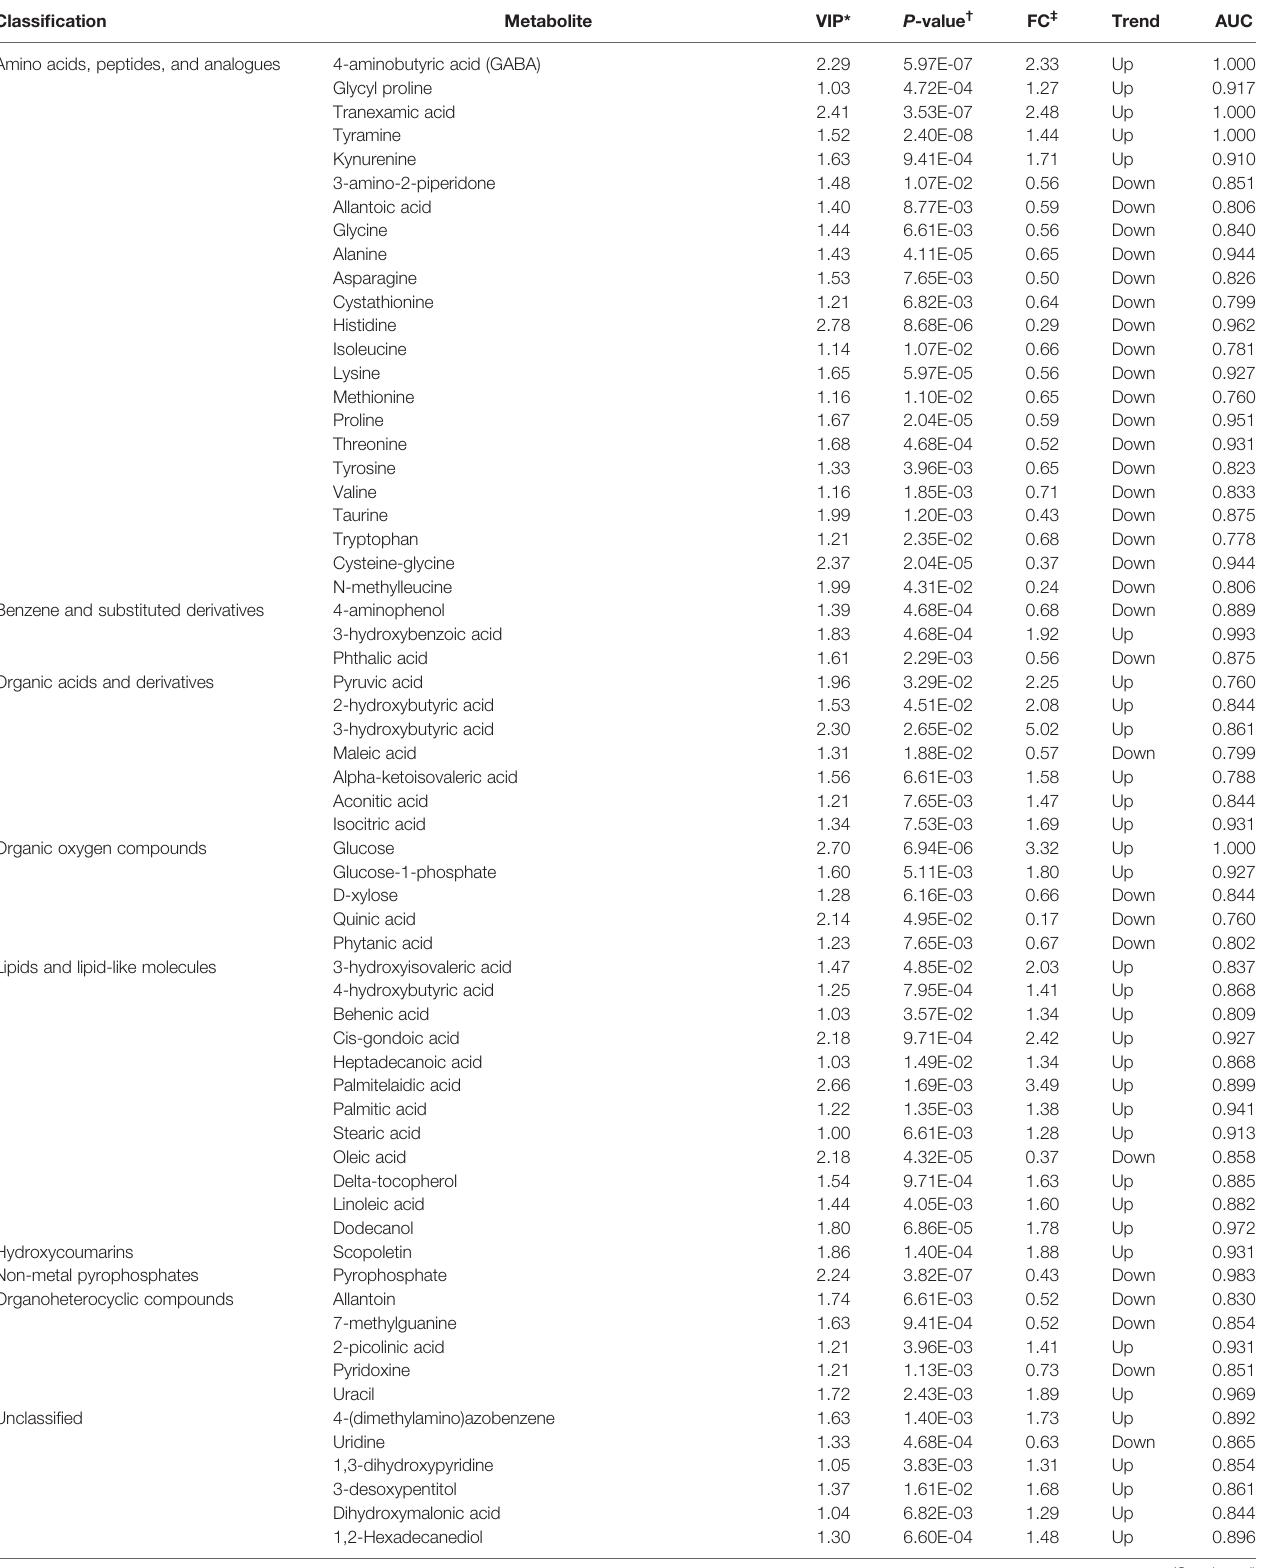
TABLE 2 | Signi fi cantly altered serum metabolites in GPP patients. Classi fi cation Metabolite VIP* P -value † FC ‡ Trend AUC Amino acids, peptides, and